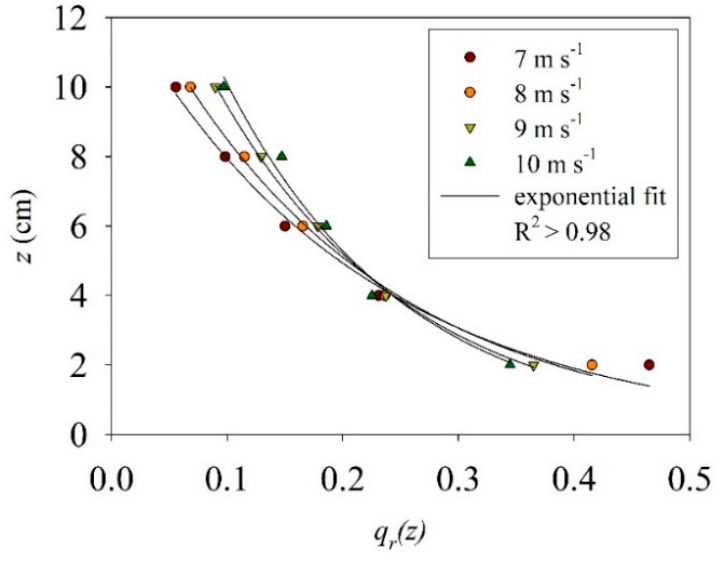
Figure 5. Vertical profiles of relative blown-sand flux q r ( z ) in Equation (3) on a flat sand surface at various wind speeds.